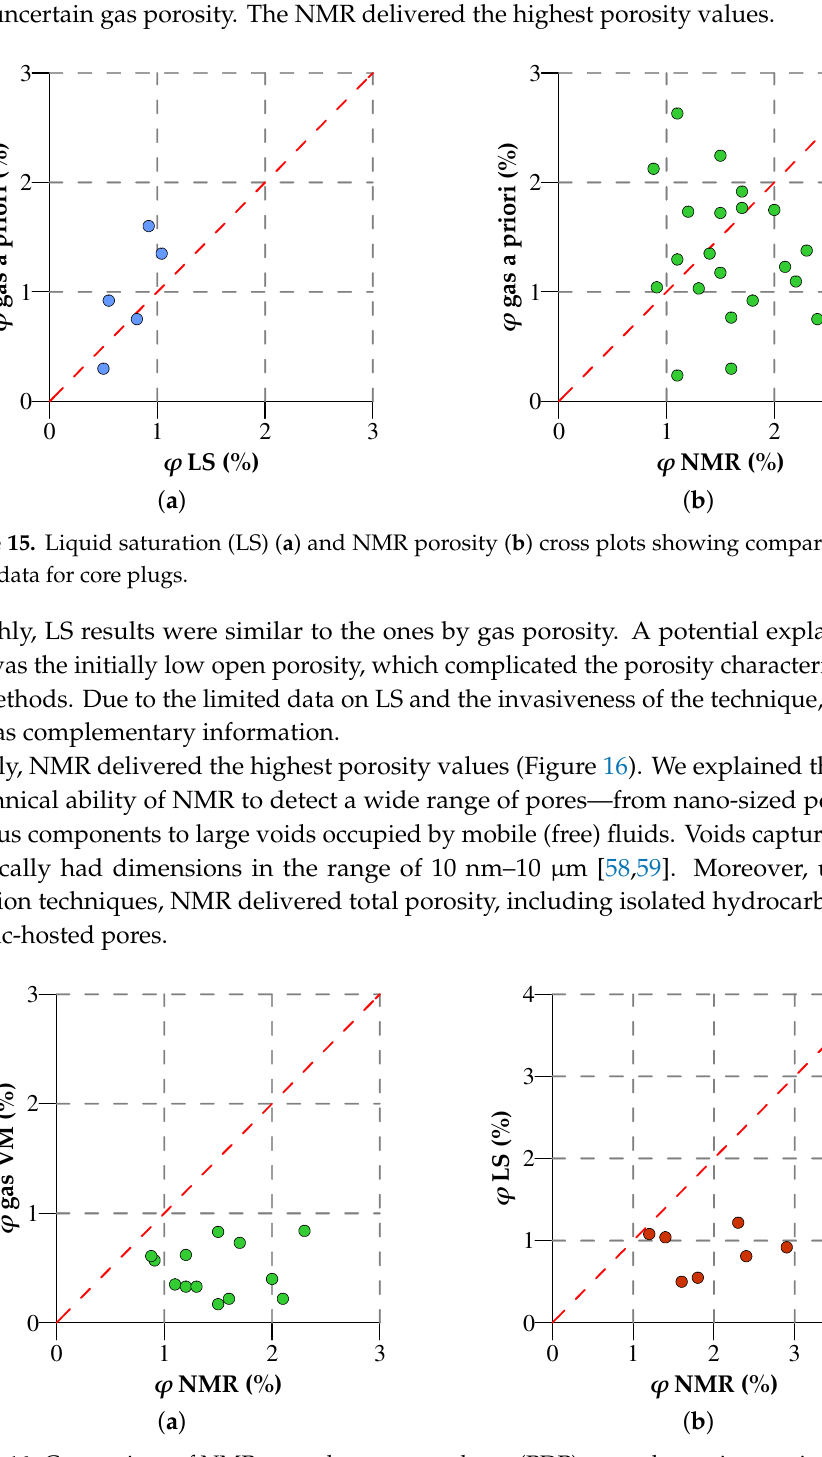
Figure 16. Comparison of NMR vs. pulse-pressure decay (PDP)-gas volumetric porosity ( a ) and LS results ( b ) on core